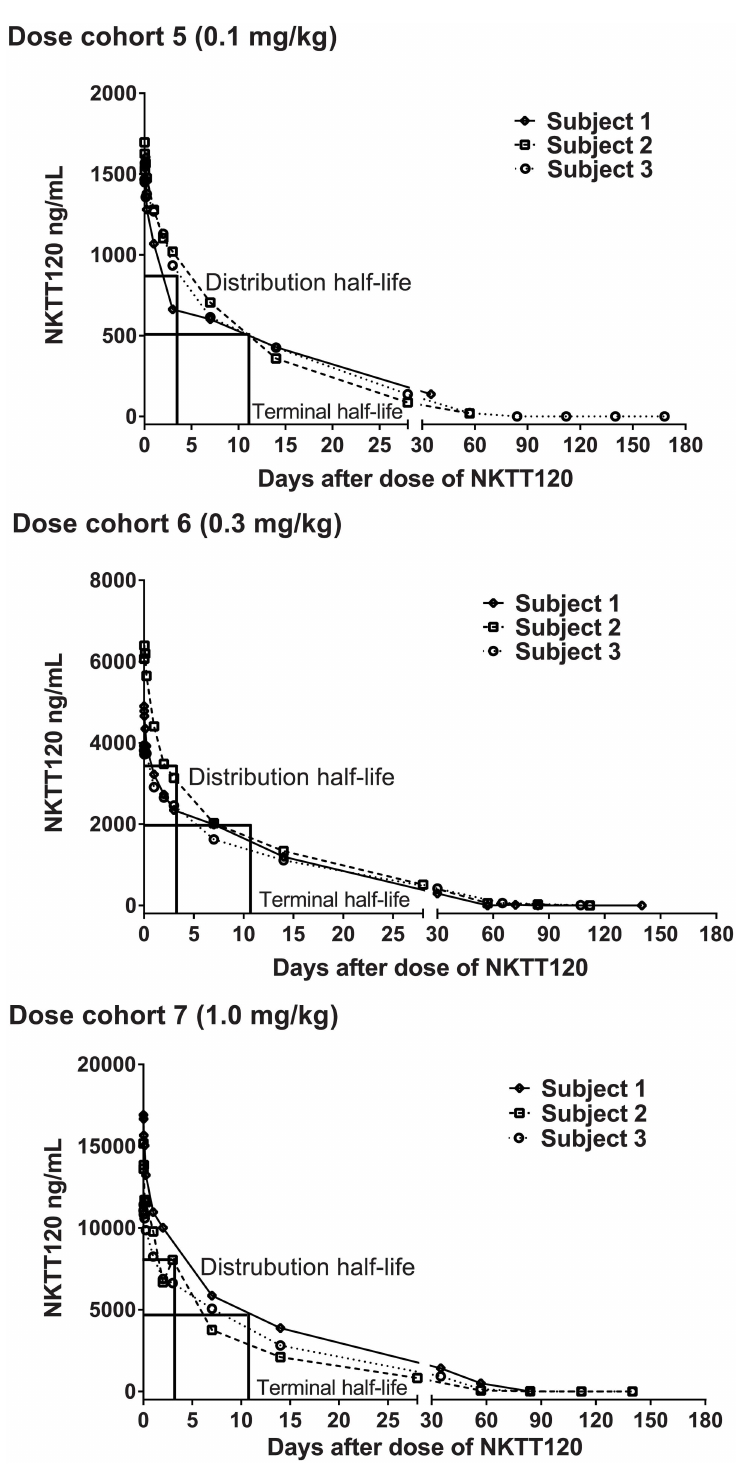
Fig 2. Median NKTT120 serum concentrations over time by dose cohort. Shown are the higherdose cohorts 5 (0.1 mg/kg), 6 (0.3 mg/kg) and 7 (1.0 mg/kg).